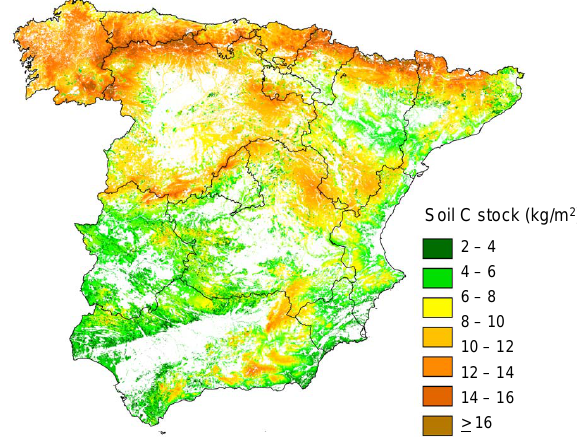
Fig. 3. Map of SOC stocks in natural non crop areas (forests, shrub- lands and pastures) of peninsular